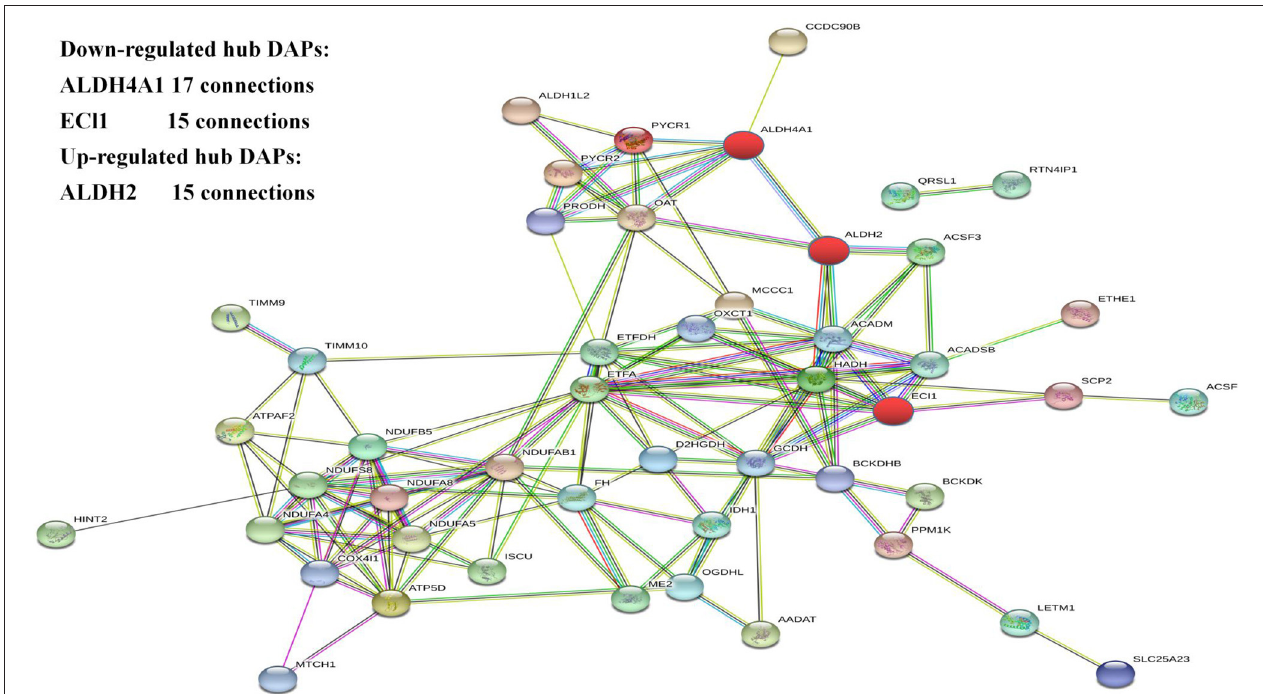
FIGURE 4 | The protein–protein interaction network generated and visualized using STRING.